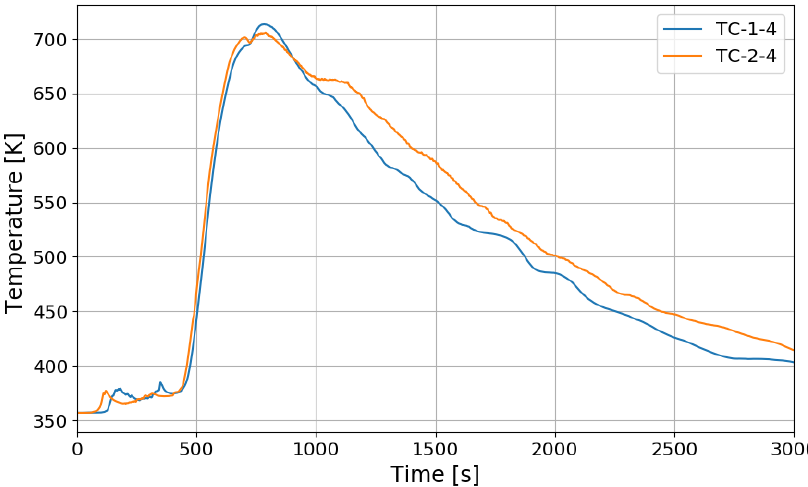
Figure 14. Temperature changes of the PARs’ catalytic plates in the SP1 test, TC ‐ 1 ‐ 4: right PAR, TC ‐ 2 ‐ 4: left PAR.